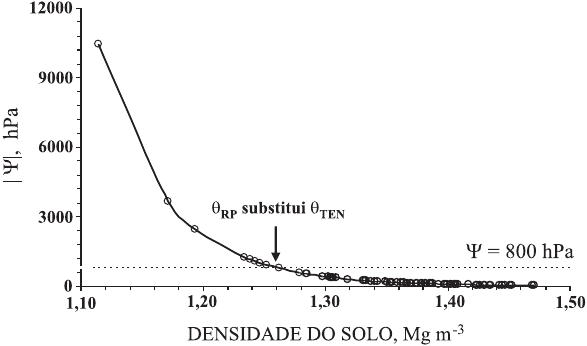
Figura 4. Variação do potencial da água no solo em função da densidade do solo.